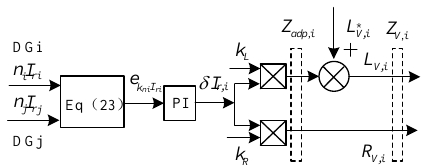
Figure 4. Virtual impendence realization scheme.